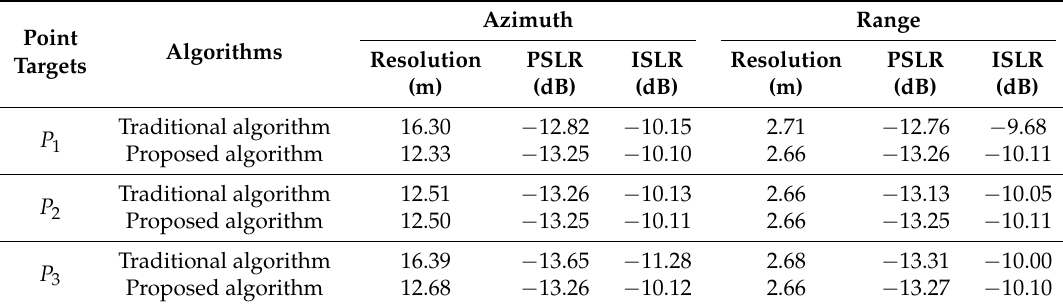
Table 2. Imaging quality analysis of comparative experiments.